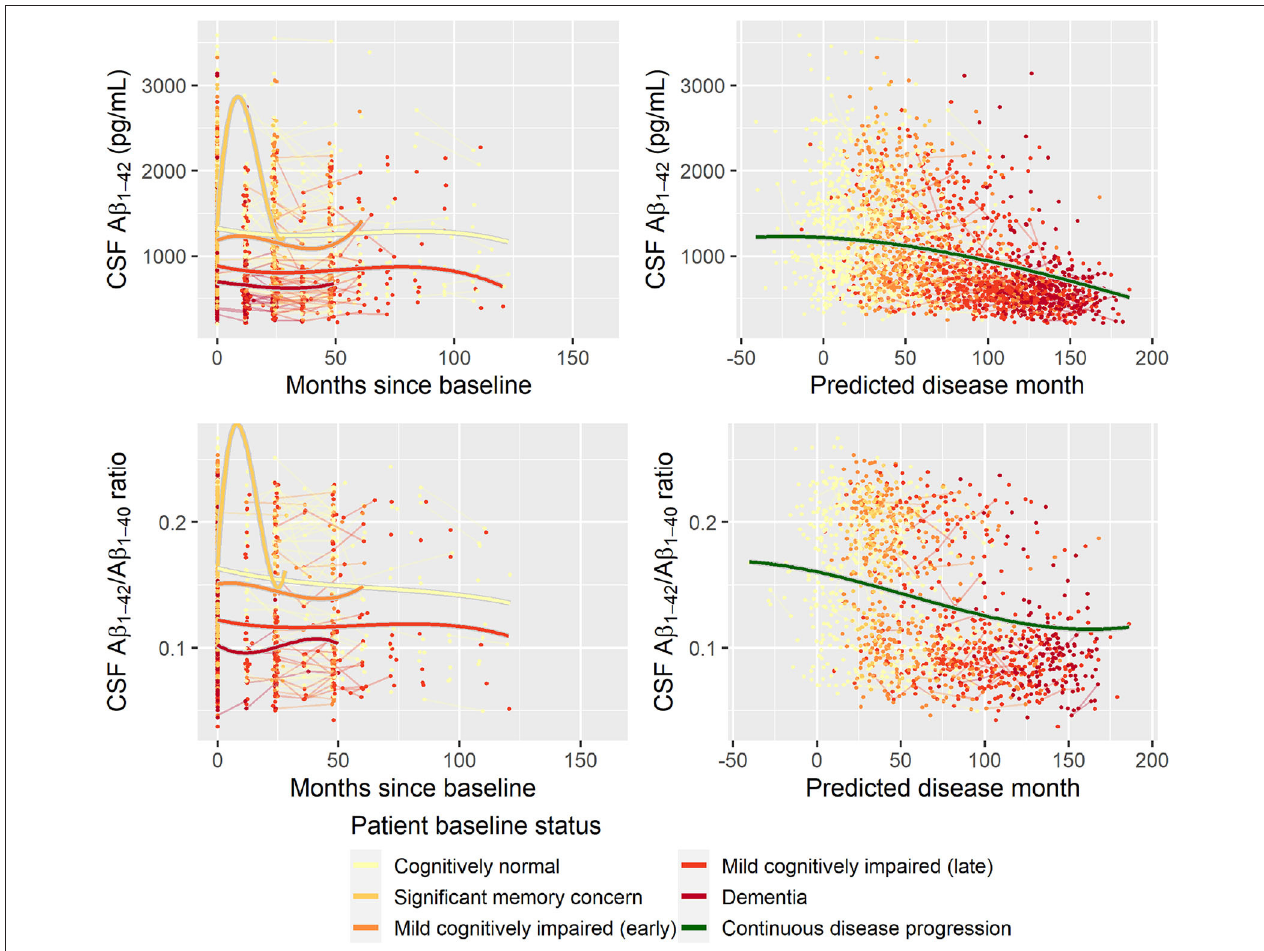
FIGURE 5 | Data and estimated biomarker trajectories for A β 1 − 42 (CSF) and A β 1 − 42 /A β 1 − 40 ratio (CSF). Left column shows results when allowing different trajectories for the five baseline groups; right column shows the results when requiring a single trajectory over predicted disease time. Note that the oscillations for the significant memory concern group occur in time periods where no data were collected for this